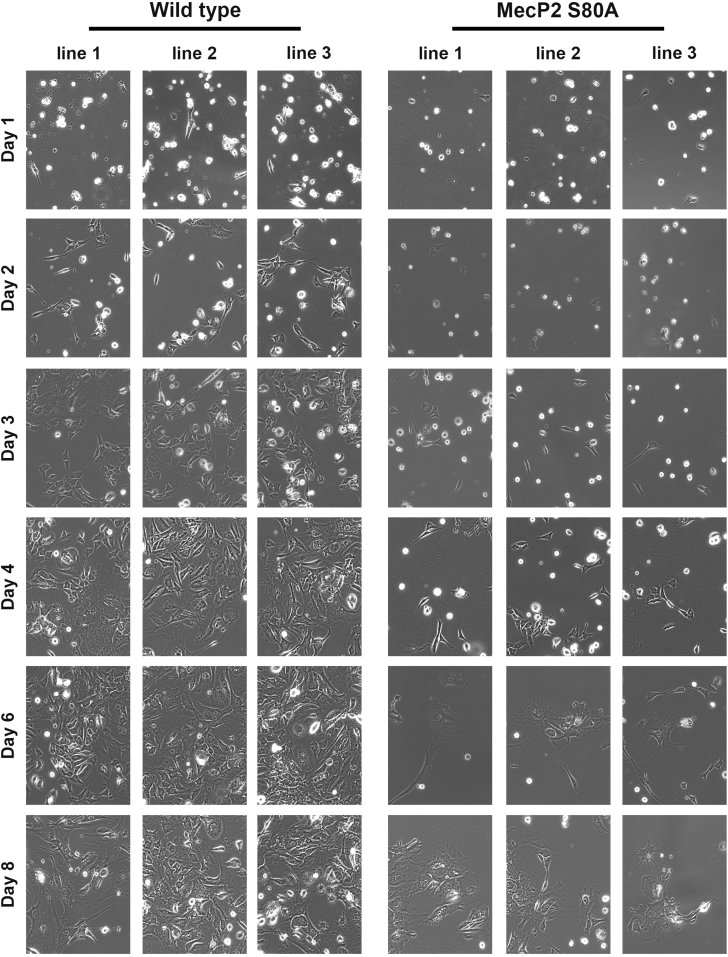
HSCs were isolated from 3 control and 3 MeCP2S80AKi mice, seeded at equal density at the start of the experiment (day 0), and allowed to transdifferentiate in vitro. Photomicrographs were taken on days 1, 2, 3, 4, 6, and 8. Representative pictures from all 3 lines from WT and MeCP2S80AKi are shown.